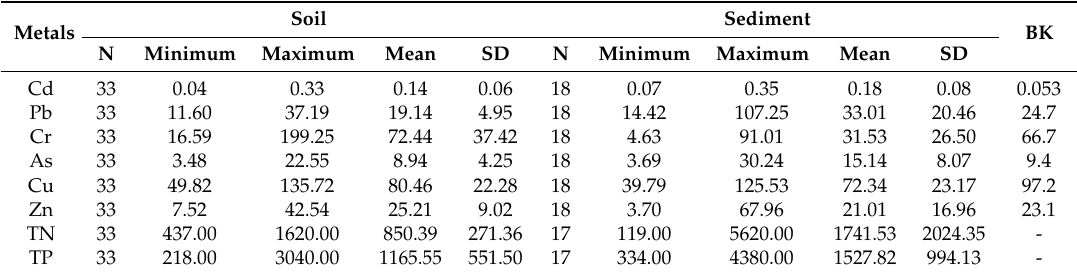
Table 4. The statistical characteristics of potentially toxic element, total nitrogen, and total phosphorus concentrations in the soil and sediment